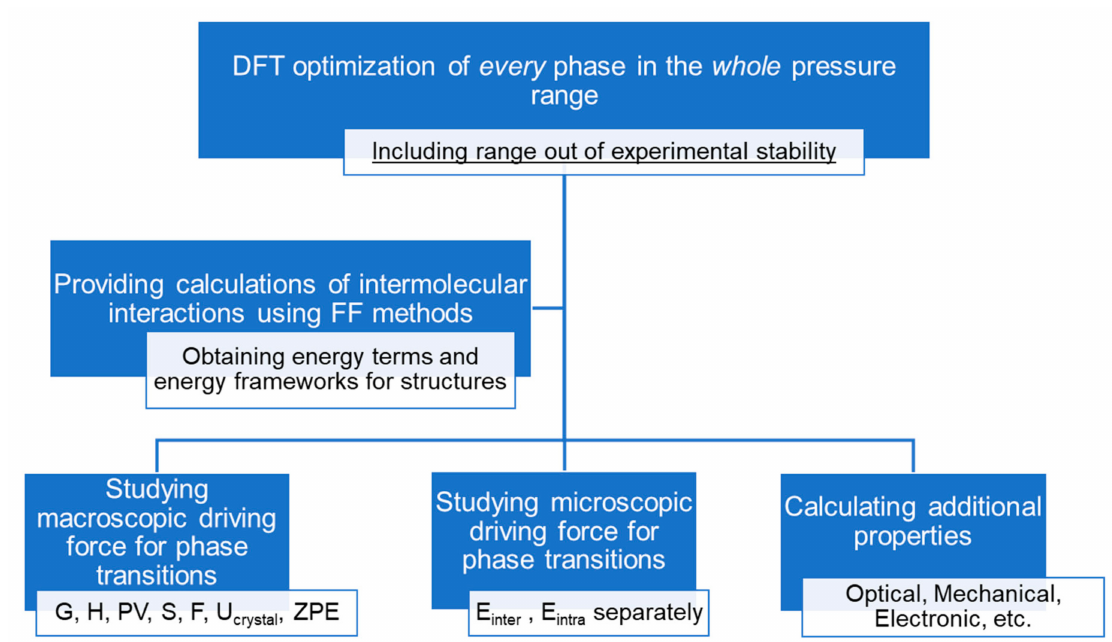
Scheme 1. A suggested scheme for the computational study of high-pressure phase transitions of molecular crystals. All steps are calculated for structures both in and out of structural stability